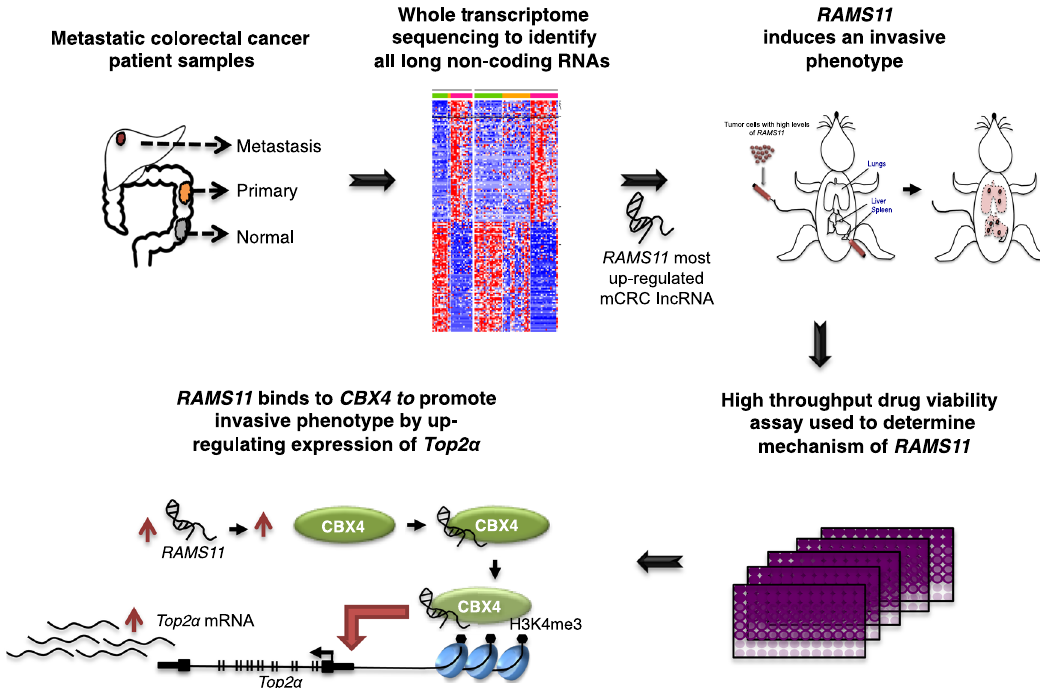
Fig. 8 RAMS11 identi fi cation and model in metastatic colorectal cancer. Process of identifying RAMS11 and model showing RAMS11 CBX4 complex binding to Top2 α promoter to increase metastatic